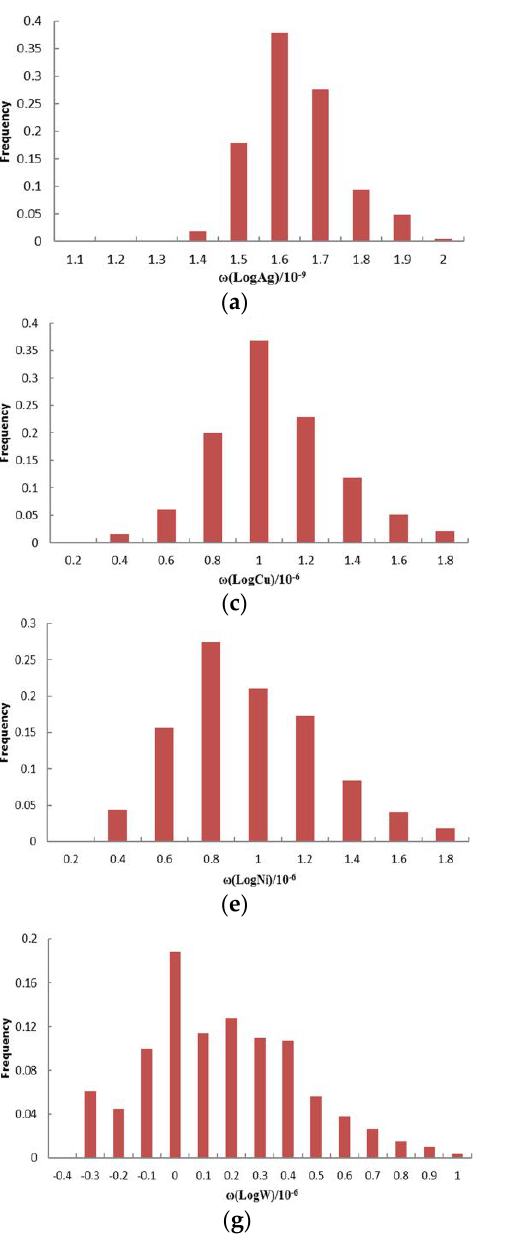
Figure 3. Frequency histograms of geochemical elements. ( a ) frequency histogram of Ag; ( b ) frequency histogram of Cr; ( c ) frequency histogram of Cu; ( d ) frequency histogram of Mo; ( e ) frequency histogram of Ni; ( f ) frequency histogram of Pb; ( g ) frequency histogram of W; ( h ) frequency histogram of Zn.